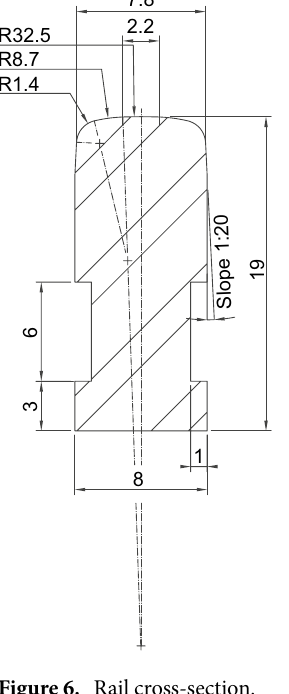
Figure 6. Rail cross-section.